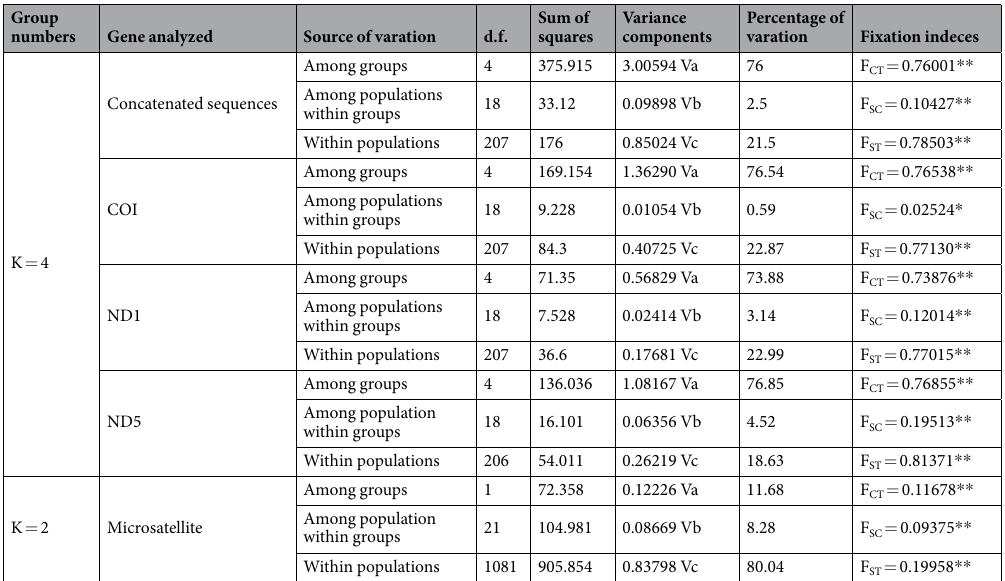
Table 2. Partitioning of genetic variation at different hierarchical levels. * Indicated p < 0.05; ** indicated p < 0.01.